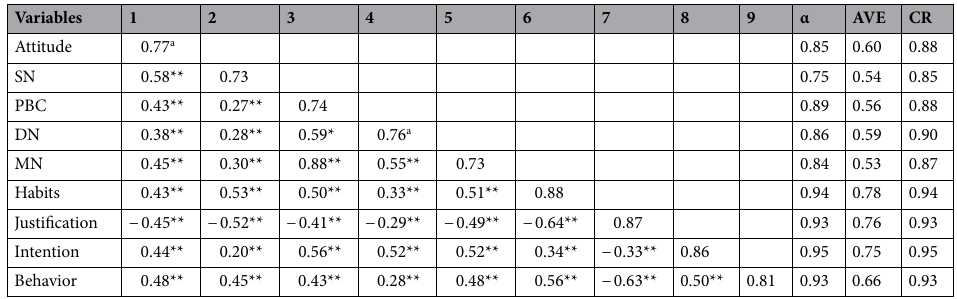
Table 2. Correlations with square roots of the AVE. a The square roots of AVE estimate. **Correlation is significant at the < 0.01